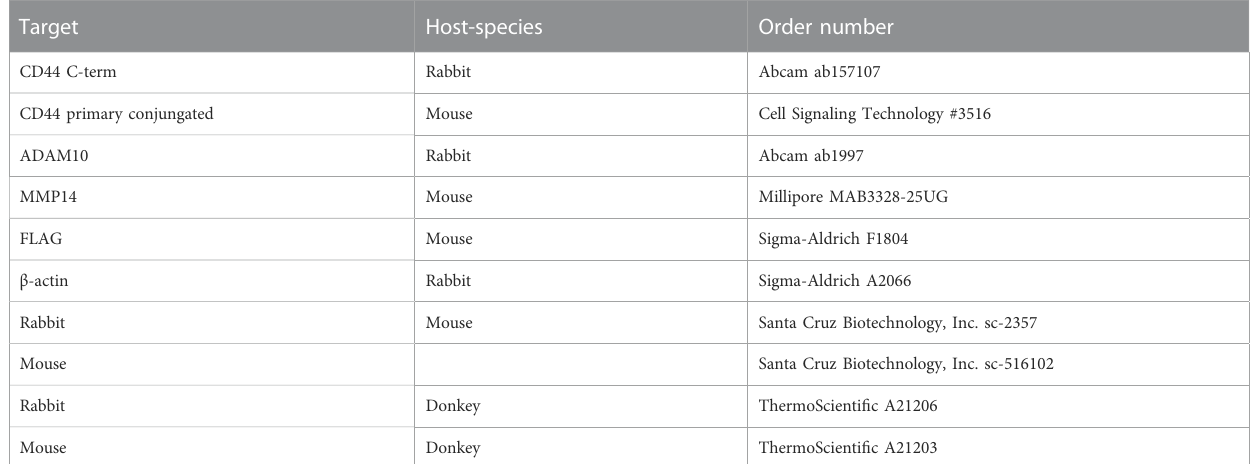
TABLE 2 List of antibodies